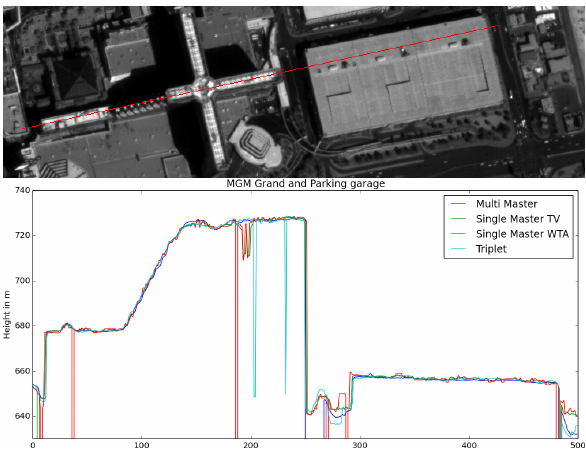
Figure 7: Profile though the MGM Grand